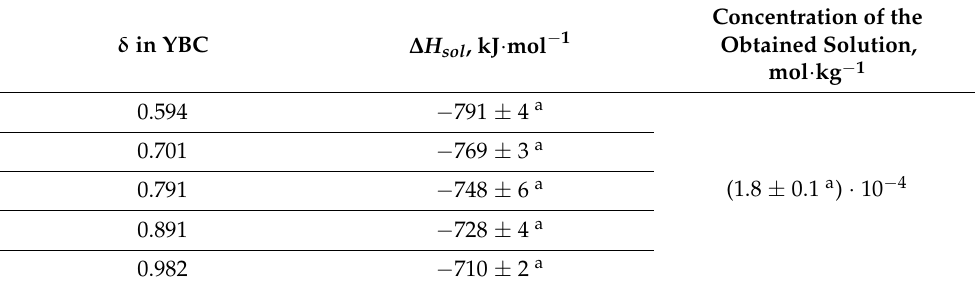
Table 4. The enthalpies of solution at 298.15 K in 4 mol · dm − 3 HCl with addition of N 2 H 6 Cl 2 , ∆ H sol , of YBC samples with different oxygen content.